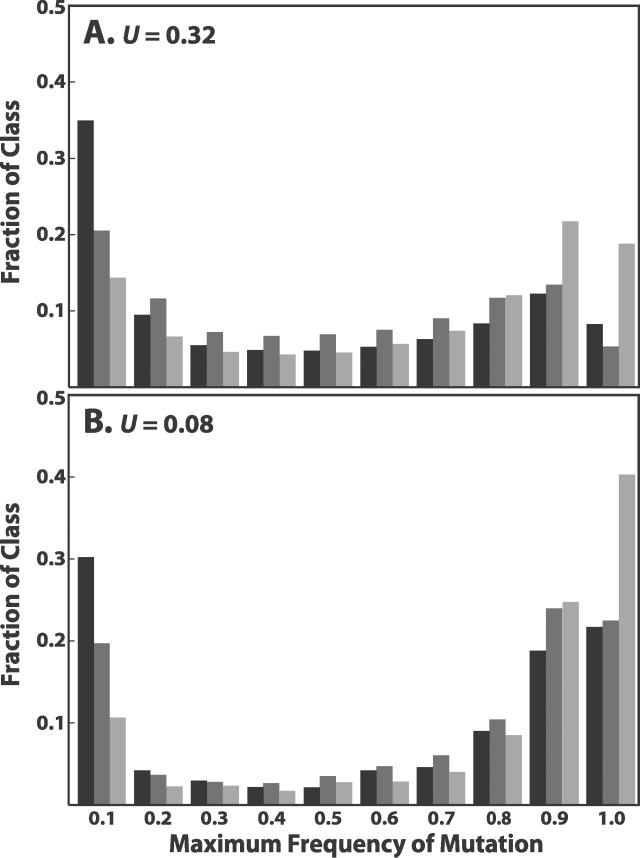
The Maximum Frequency of Ancestral Mutations (Those Forming the Dominant Mutational Lineage from the Founding Population to the MRCA of the Ending Population) That Did Not FixThe black, dark gray, and light gray bars correspond to mutations with initial fitness effects that are deleterious, neutral, and beneficial, respectively. The x-axis is the upper bin bound for the frequency attained (e.g., 0.20 includes those mutations whose maximum frequency is greater than 0.10 and less than or equal to 0.20). The y-axis is the fraction of mutations in each class that attained each frequency range. The top pane (A) shows the frequency distribution for U = 0.32, and the bottom pane (B) depicts U = 0.08.